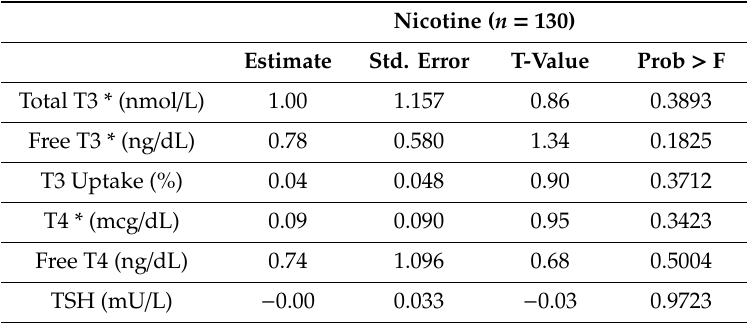
Table 8. Interaction of fetal thyroid hormones with nicotine.